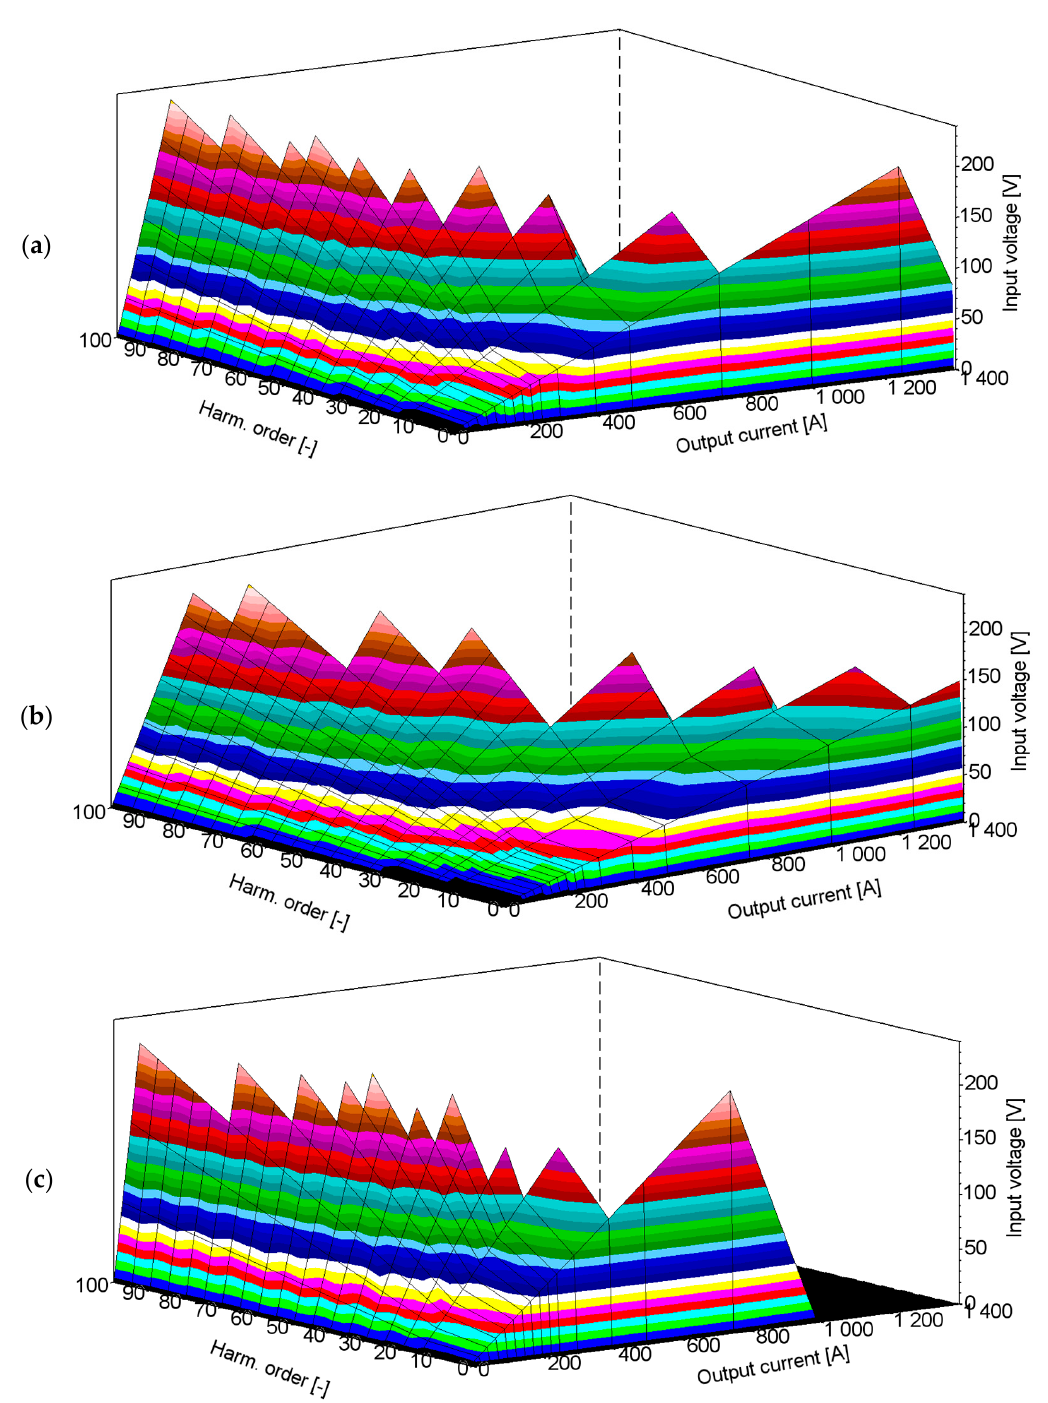
Figure 6. The calculated distorted output current with a given harmonic order for the supplied primary voltage obtained for serial connection of the primary winding’s sections and parallel connection of the secondary winding’s sections: ( a ) R L = 0.3 m Ω ; L L = 3 μ H, ( b ) R L = 0.3 m Ω ; L L = 1.5 μ H, ( c ) R L = 0.3 m Ω ; L L = 6 μ H.